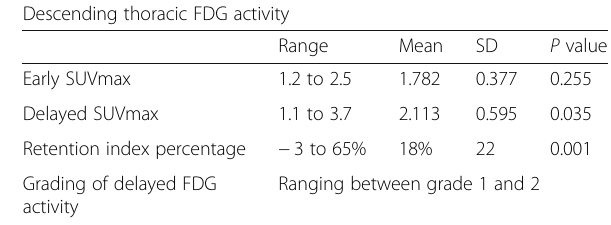
Table 3 Dual point hepatic SUVs and Retention index percentage in the 50 patients of study